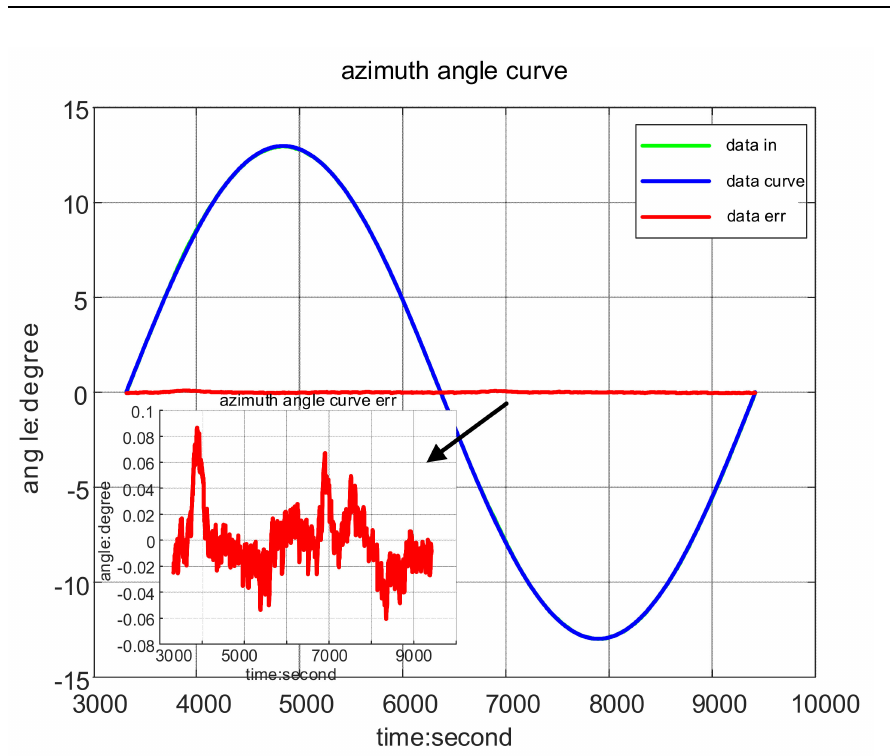
Figure 6. Fitting results in the first orbit of the spring